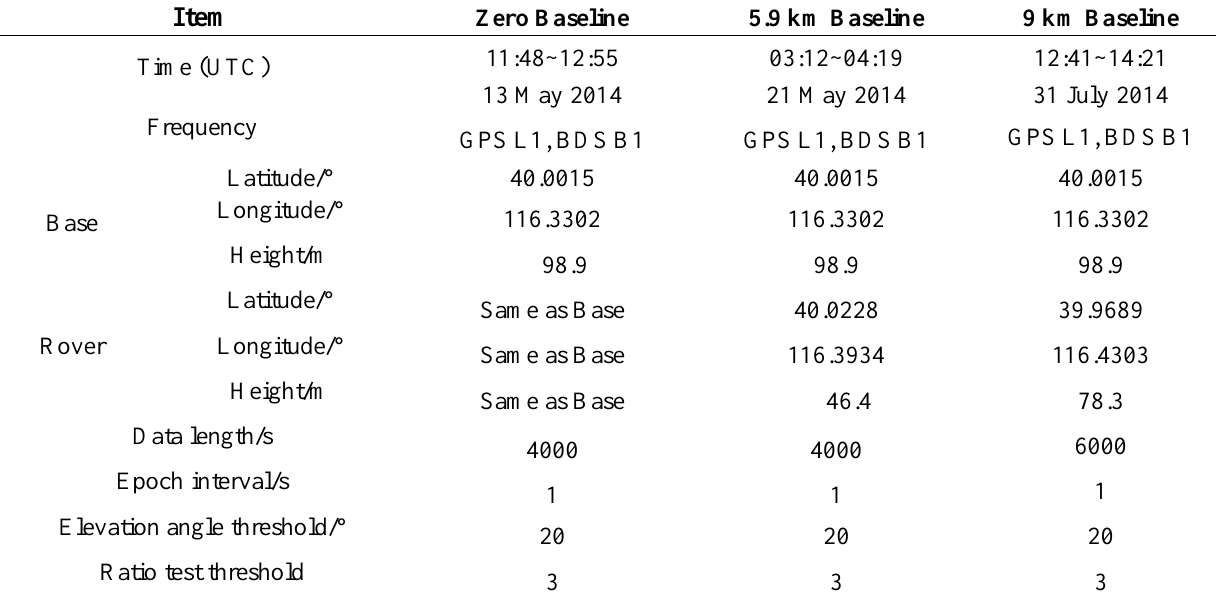
Table 1. Experiment